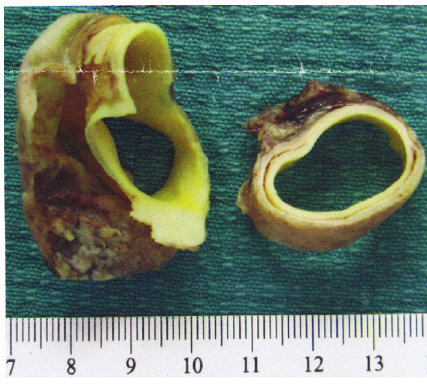
Figure 3: Aortic dissection flap and aortic